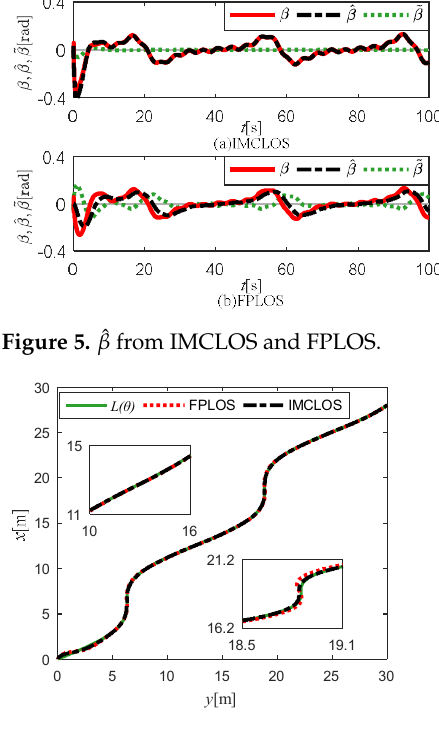
Figure 6. Path following simulation results.